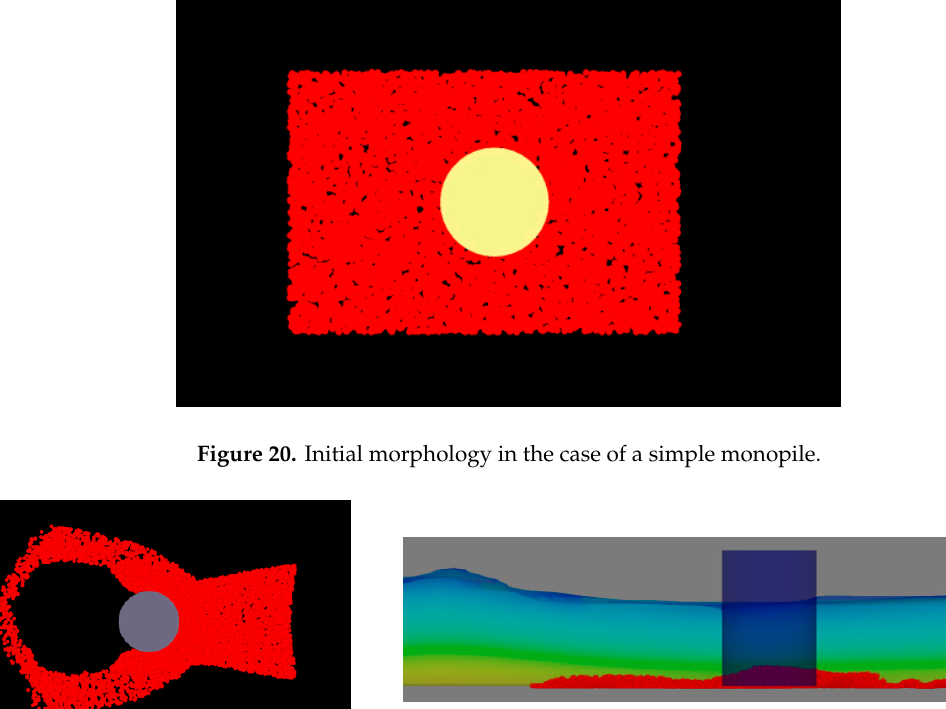
Figure 19. Dimensions of the hybrid mono-pile.